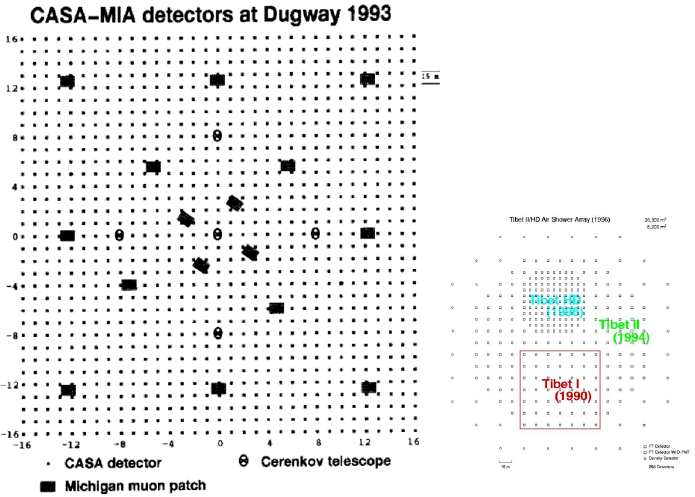
Figure 1. Schematic of layouts of the CASA-MIA array and AS γ in phases before